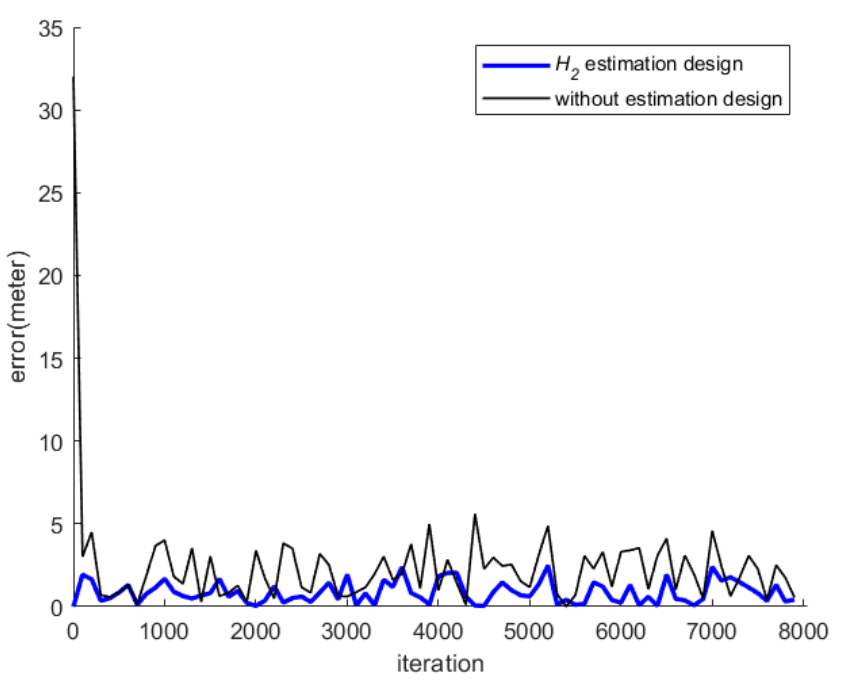
Figure 9. The indoor positioning result of the proposed H 2 estimation design (simulation).